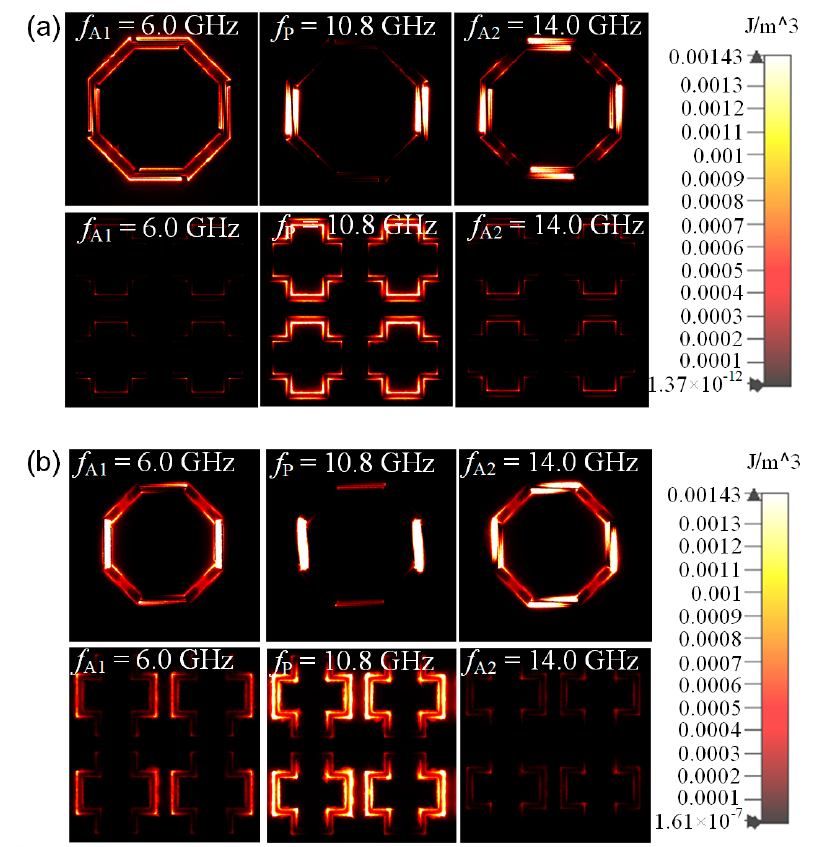
Figure 6. ( a ) Electric field energy and ( b ) magnetic field energy distribution under TE polarization of the lossy layer and bandpass layer at f A1 , f P and f A2 .